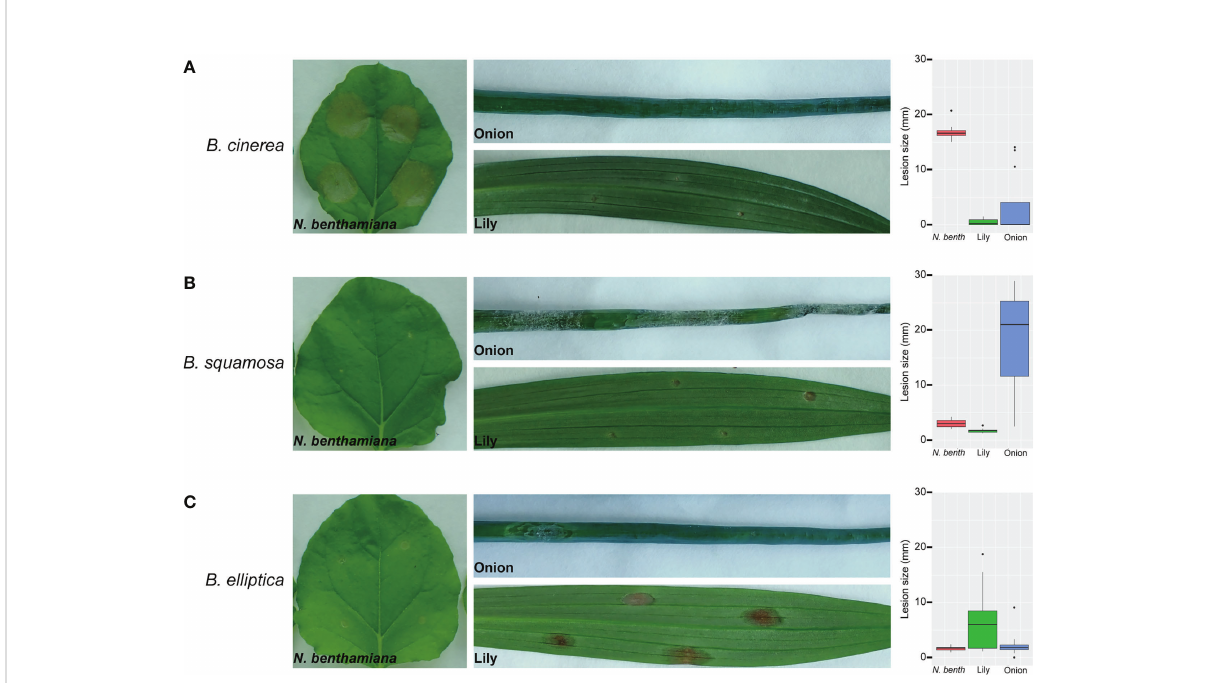
FIGURE 1 Inoculation of B. cinerea (A) , B. squamosa (B) and B. elliptica (C) on ( N. benthamiana ), onion and lily leaves con fi rms host-speci fi city. Disease symptoms were observed at 4dpi and box plot diagrams represent the lesion diameters at 4dpi upon inoculation of the different Botrytis species on the respective plants. Each box represents all compiled lesion diameters (in mm) for a given host